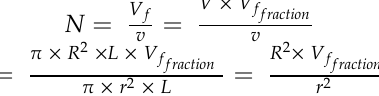
( b ), longitudinal view from nano-CT scanning showing fiber orientation ( c ) and 3D view taken using